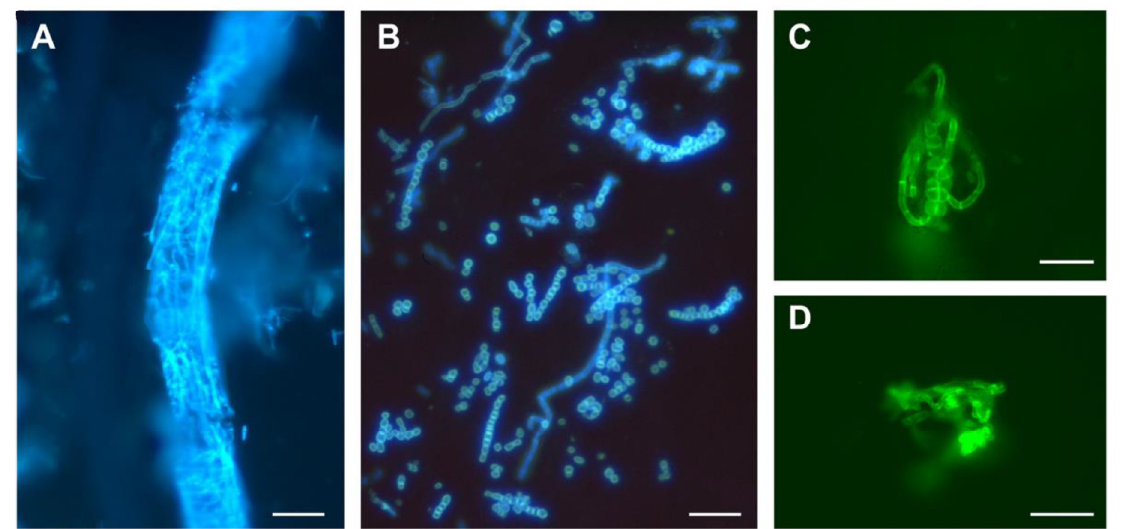
Figure 1. Direct mycological examinations of animal samples. ( A ) Sleeve of septate filaments around a cat hair (bar = 40 µ m). ( B ) Round arthrospores in strings of pearls around an infected dog hair (bar = 20 µ m). ( C , D ) Pellet-like accumulations of twisted hyphae from asymptomatic guinea pigs (bar = 20 µ m). The sample preparations were observed with a fluorescence microscope using excitation between 360 and 400 nm ( A , B ), and between 400 and 440 nm ( C , D